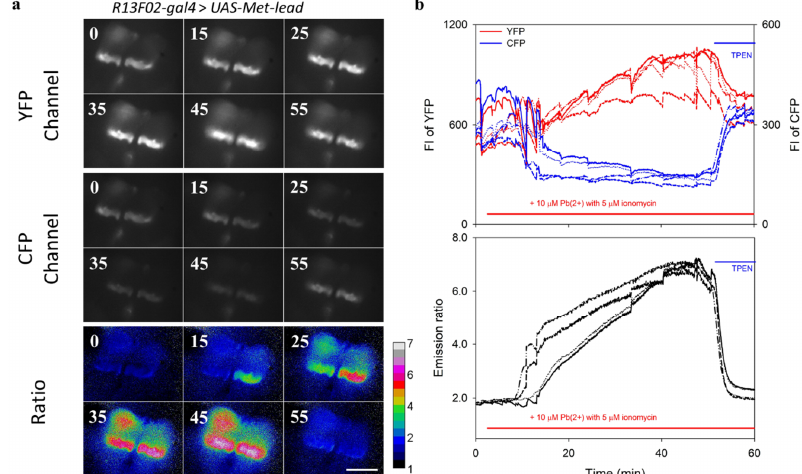
Figure 4. Application of Met-lead to adult Drosophila fly brains. ( a ) Images of Drosophila (R13F02-gal4 > UAS-Met-lead) fly brains were taken using an upright FRET platform. During a 60-minute recording, a bu ff er containing lead ions (10 µ M) and ionomycin (5 µ M) was added at around the 2 min time point (the red bar shown in the top and bottom graphs in panel ( b )). The lead ion chelator TPEN (100 µ M) was then added from around the 55 min time point until the end of the recording (the blue bar in panel ( b )). Representative images of fly brains (the mushroom body) in the YFP channel (6 graphs numbered with the time points in minutes, top), in the CFP channel (middle), and in a ratio (YFP / CFP, bottom) are shown. The rainbow-color images were combined through a ratio imaging process. ( b ) Time-lapse plots from selected regions are displayed as fluorescent intensities (FIs) (YFP in red lines; CFP in blue lines, the top graph in panel ( b )) and emission ratios (the bottom graph in panel ( b )). The scale bar is 100 µ m, and the rainbow color ratio bar is